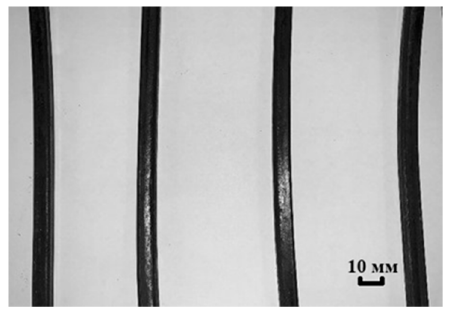
Figure 3. The resulting bars 10 × 10